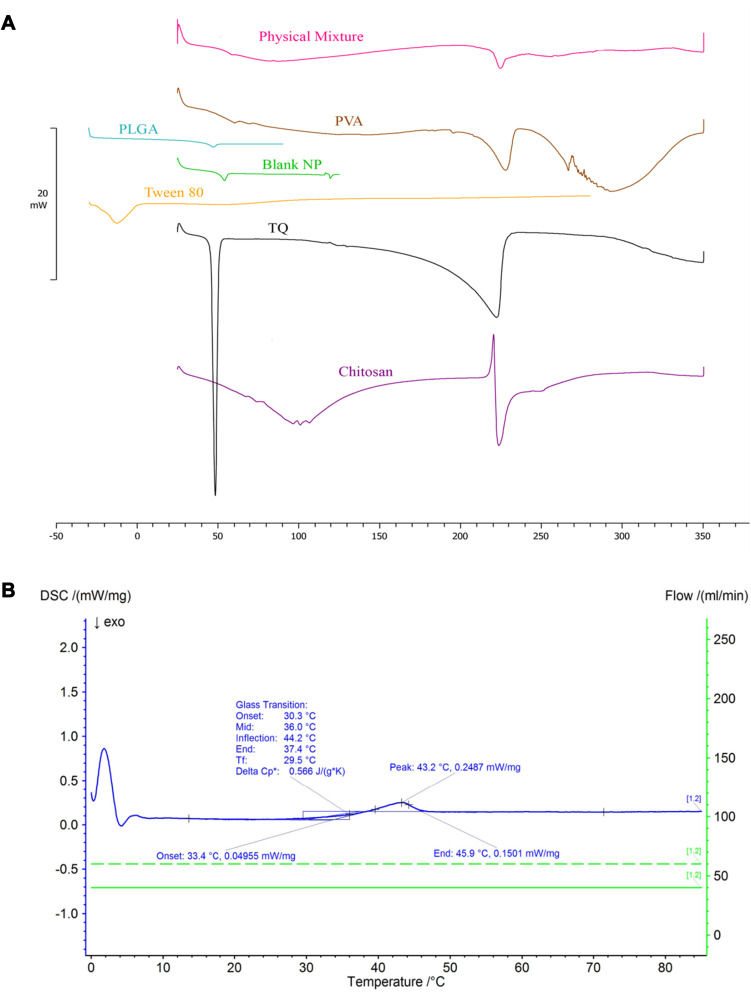
DSC thermograms of (A) TQ and the components in the NP formulation, physical mixture, and blank NPs and (B) TQ-PLGA NPs.